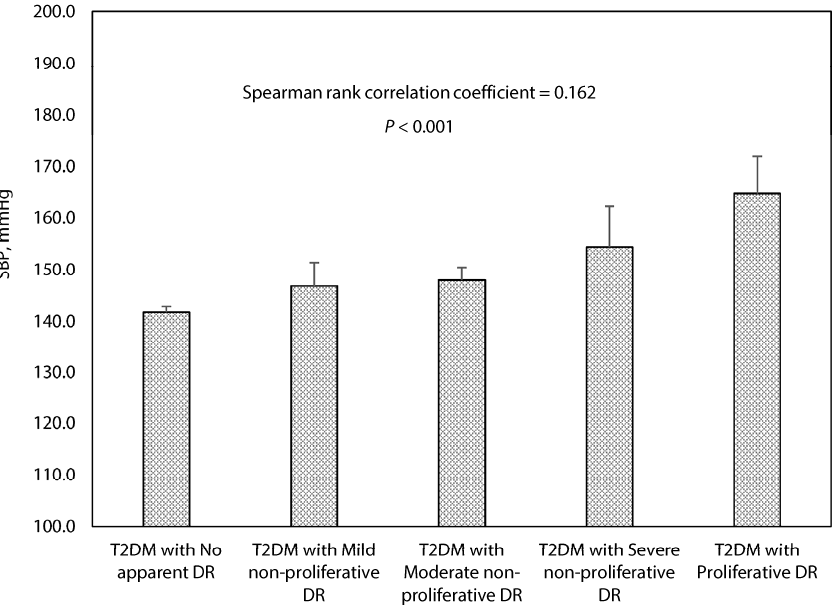
Figure 1. Association between systolic blood pressure and the grading of diabetic retinopathy in T2DM patients with concurrent hypertension. Error bars indicate 95% confidence interval. BP, blood pressure; DR, diabetic retinopathy. The stages of diabetic retinopathy are classified using the International Classification of DR Scale. Reference: International Diabetes Federation and the Fred Hollows Foundation. Diabetes eye health: a guide for health care professionals. Brussels, Belgium: International Diabetes Federation, 2015.